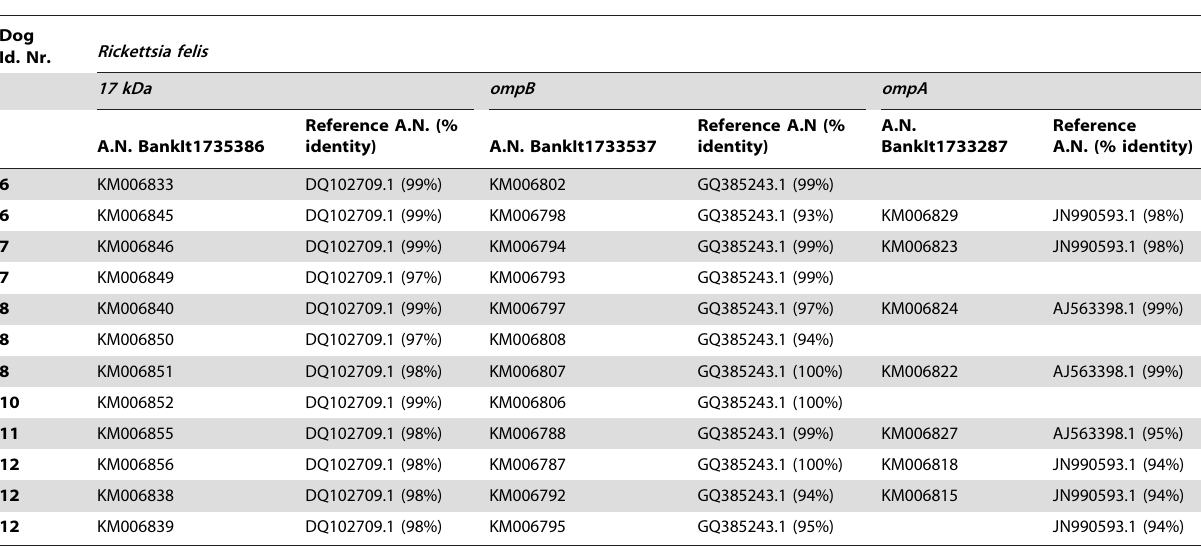
Table 3. Sequencing results for Rickettsia spp. positive C. felis collected from dogs.